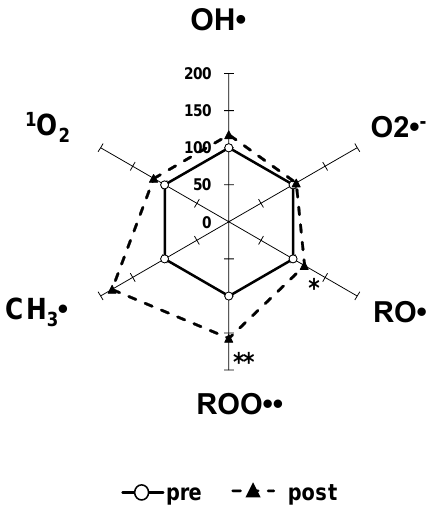
Figure 1. The changes in the scavenging activity of six reactive oxygen species in the 10 subjects’ serum (%) from pre-exercise (100%) to post-exercise. The standard substance equivalent of each mean pre-exercise value was set as 100%, and the relative post-exercise values were calculated. The total area of the radar chart increased 178% from that in pre-exercise. * p < 0.05, ** p < 0.01 vs.